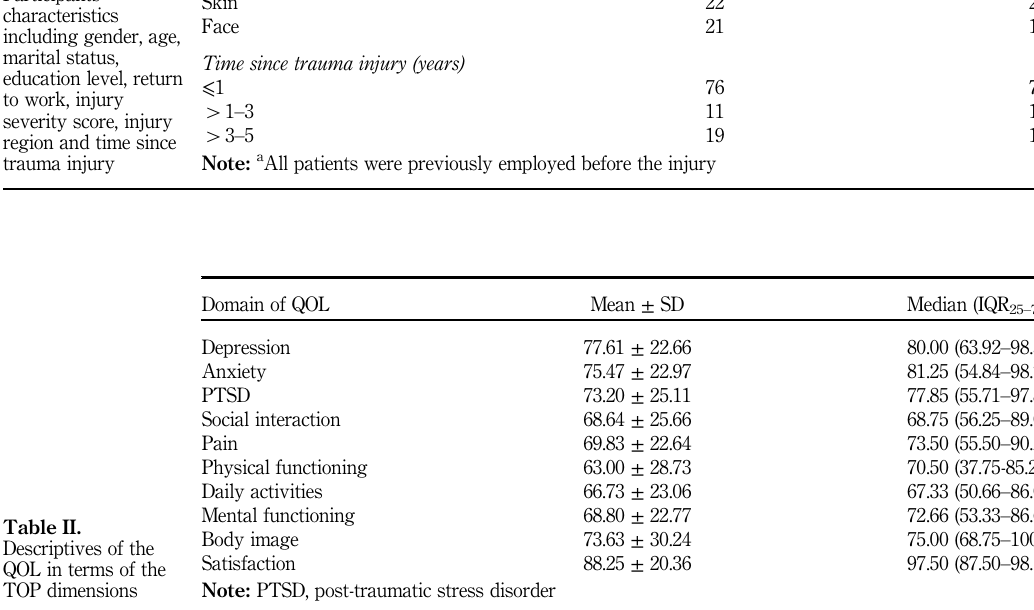
QOL in terms of the TOP